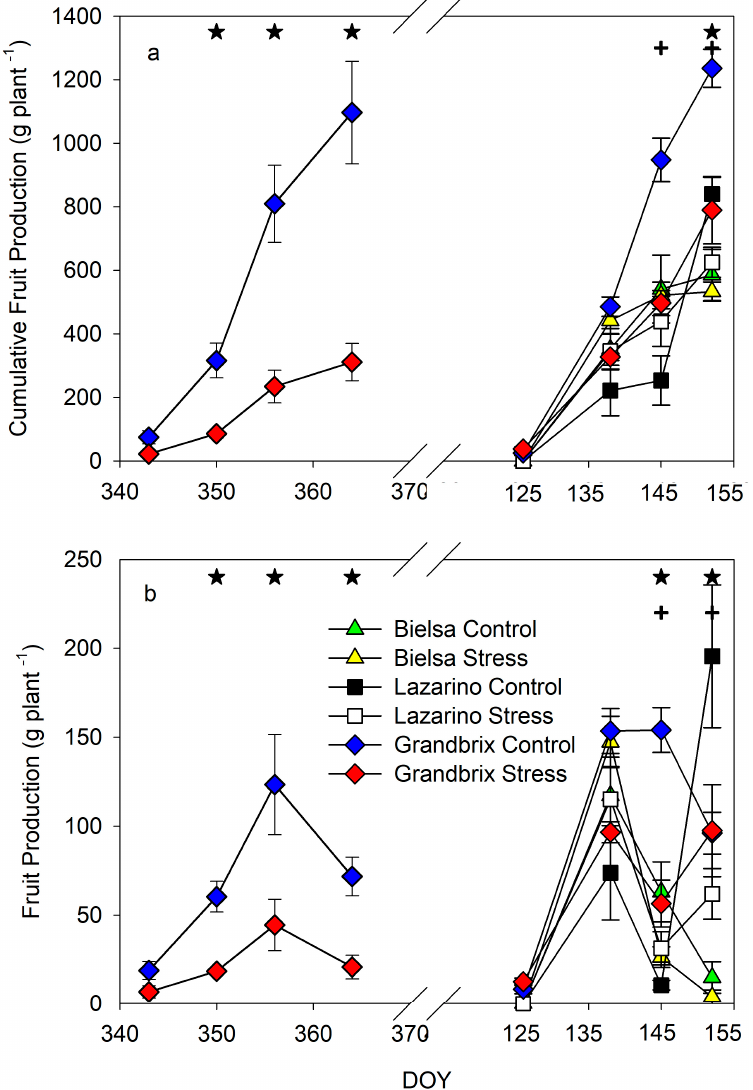
Figure 8. Pattern of cumulative fruit production ( a ) and weekly fruit production ( b ) during both experiments. Each symbol is the average of 4 (autumn cycle) or 3 (spring cycle) data. Vertical bars represent the standard error. Asterisks (irrigation treatments) and crosses (cultivars) indicate the date when significant differences were found ( p < 0.05).